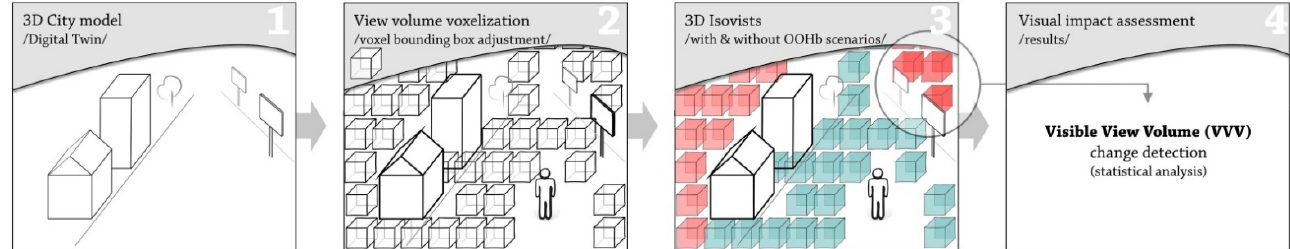
Figure 4. The method workflow steps: (1) a case study 3D city model creation through open geospatial data integration in 3D-GIS software; (2) filling the empty space remaining in the 3D model with voxels; (3) the voxel visibility determination using 3D Isovist calculated in OOHb-free and OOHb scenario; (4) the visible view volume change detection and statistical significance test.